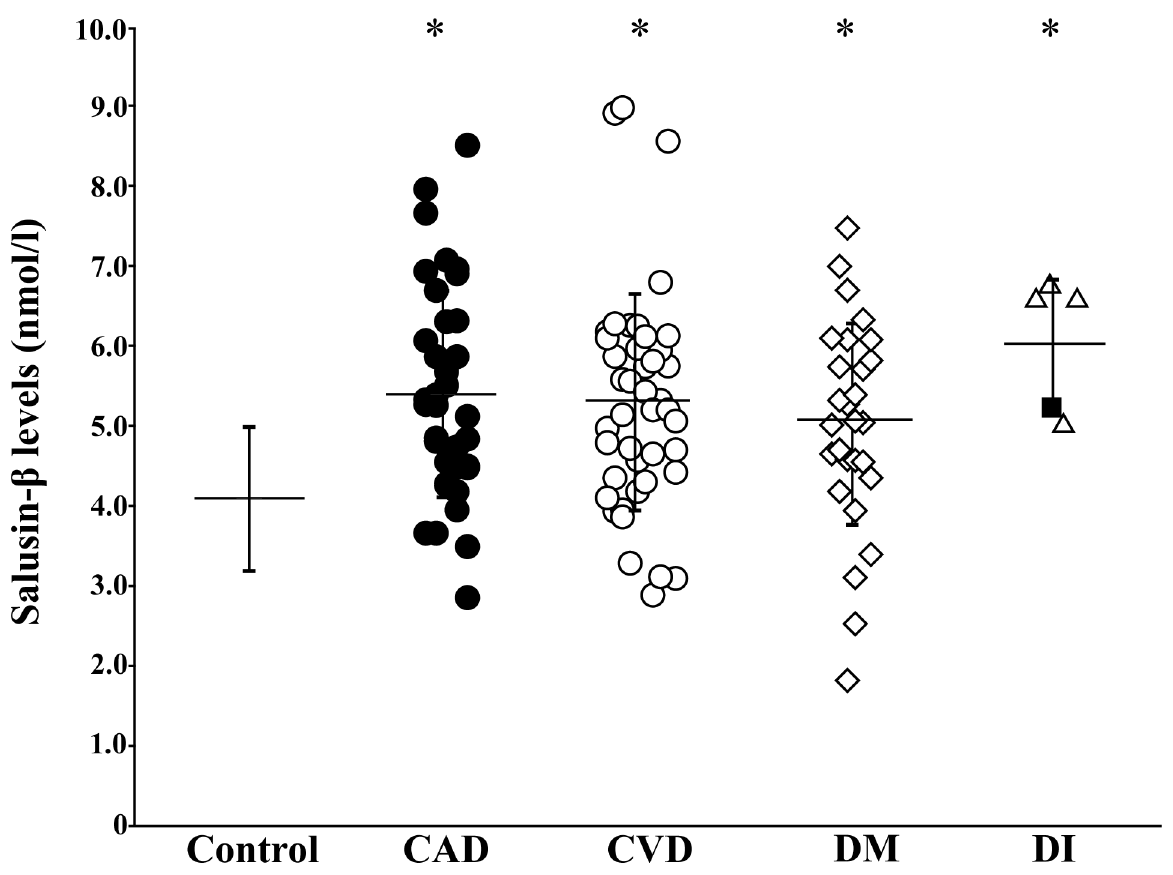
insipidus. Distribution of plasma salusin-β levels from 37 patients with angiographically proven coronary artery disease (CAD), 43 patients with cerebrovascular disease (CVD), 28 patients with diabetes mellitus (DM), and five patients with panhypopituitarism and complete central diabetes insipidus (DI). Each point represents the salusin-β concentration found in a single subject and the horizontal bars indicate the mean salusin-β concentration for each group. The horizontal bar with the vertical line in the left lane shows the mean ± SD of 106 healthy subjects for comparison. * P < 0.0001 vs. healthy controls. A closed square in the DI group represents the plasma salusin-β concentration of a 47-year-old man with panhypopituitarism and complete DI due to a completely severed pituitary stalk induced by a traumatic brain